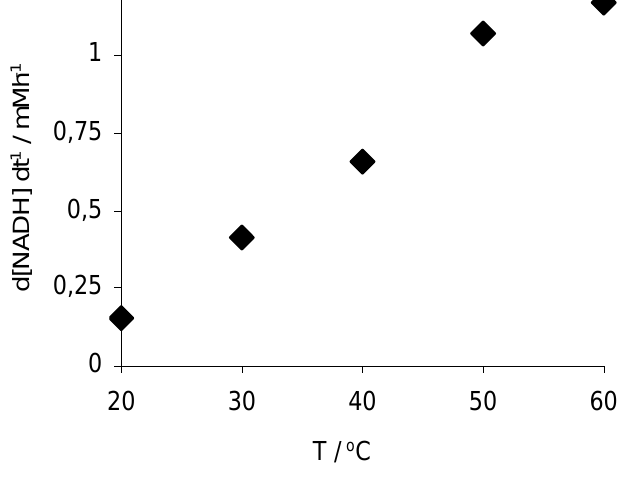
, expressed as TOF(Rh). 0 ) = 150 mM, 2